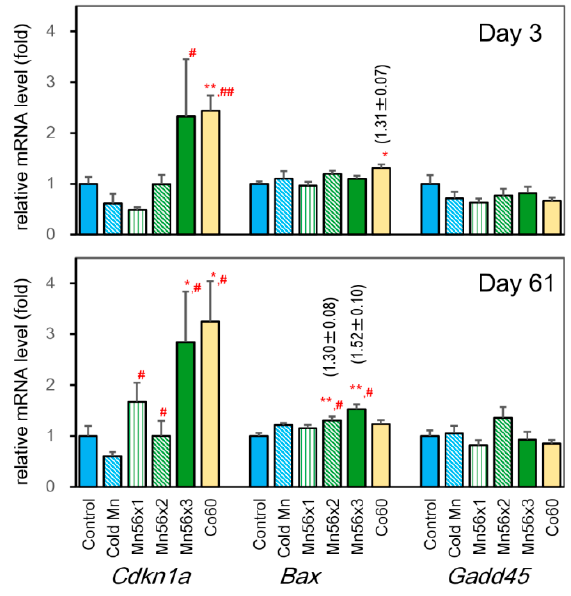
Figure 2. Relative mRNA expression levels of Cdkn1a , Bax , and Gadd45 genes in the liver of rats on day 3 (top) and day 61 (bottom) after the exposure. Control (solid blue): untreated group; Cold Mn (diagonal blue stripes): exposed to stable MnO 2 particles; Mn56x1 (green stripes), Mn56x2 (diagonal green stripes), and Mn56x3 (solid green): exposed to 56 MnO 2 particles at the activity of 2.6 × 10 8 , 5.5 × 10 8 , and 8 × 10 8 Bq, respectively; Co60 (solid yellow): exposed to 60 Co γ -rays (2 Gy). * p < 0.05 and ** p < 0.01 vs. control; # p < 0.05 and ## p < 0.01 vs. Cold Mn.